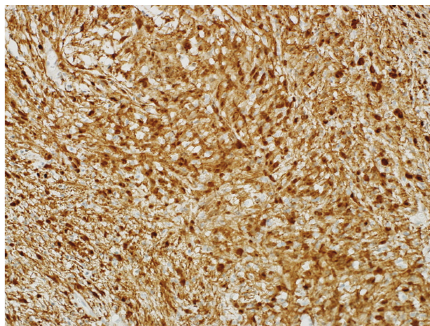
Figure 3: Immunohistochemical examination of the pleural mass: the tumor cells stained positive for S100